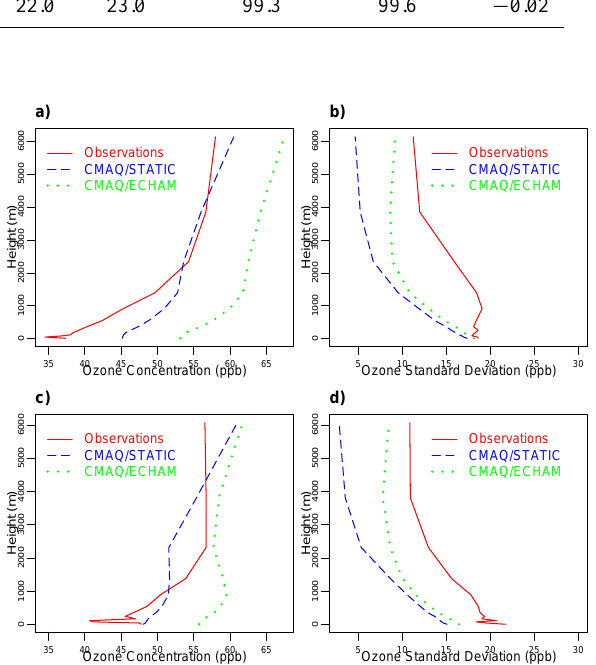
Fig. 13. Observed and simulated vertical profiles of the mean and standard deviation of ozone concentrations across all available launches at the two ozonesonde sites described in Sect. 2. (a) mean concentrations at Wallops Island, (b) standard deviations at Wallops Island, (c) mean concentrations at Huntsville, (d) standard devia- tions at